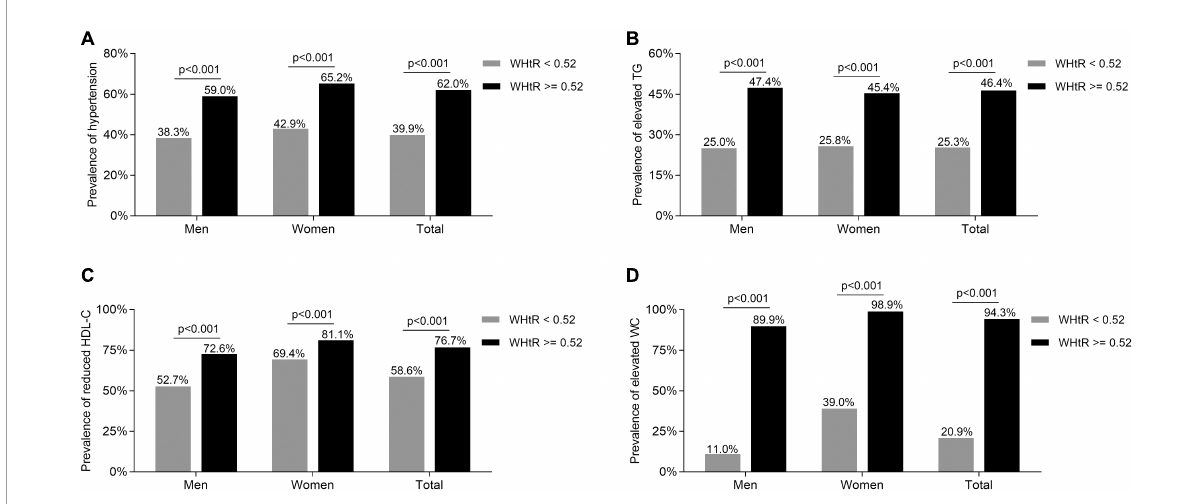
FIGURE2 Comparisons of the MetS components between the T2DM subjects with WHtR < 0.52 and ≥ 0.52. (A) Comparison of the prevalence of hypertension stratified by sex between the subjects with WHtR < 0.52 and ≥ 0.52 after adjusting for age and DD. (B) Comparison of the prevalence of elevated TG stratified by sex between the subjects with WHtR < 0.52 and ≥ 0.52 after adjusting for age and DD. (C) Comparison of the prevalence of reduced HDL-C stratified by sex between the subjects with WHtR < 0.52 and ≥ 0.52 after adjusting for age and DD. (D) Comparison of the prevalence of elevated WC stratified by sex between subjects with WHtR < 0.52 and ≥ 0.52 after adjusting for age and DD.